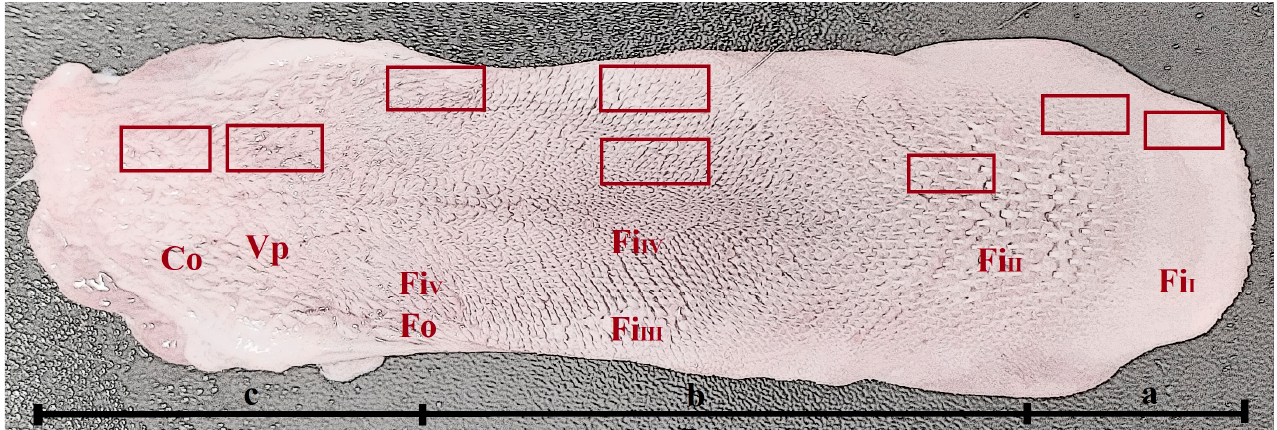
Figure 1. Macroscopic view of the dorsal surface of the tongue of N. nebulosa. Division of the tongue into apex ( a ), body ( b ) and root ( c ). See the areas (rectangles) for the collection of samples for histological and histochemical analyses. Abbreviations : Co—conical papillae; Fi I , Fi II , Fi III , Fi IV and Fi V —types of filiform papillae; Fu—fungiform papillae; Fo—foliate papillae. Gustatory papillae with taste buds include fungiform, vallate and foliate papillae,